Question: Summarize what this figure shows in one sentence.
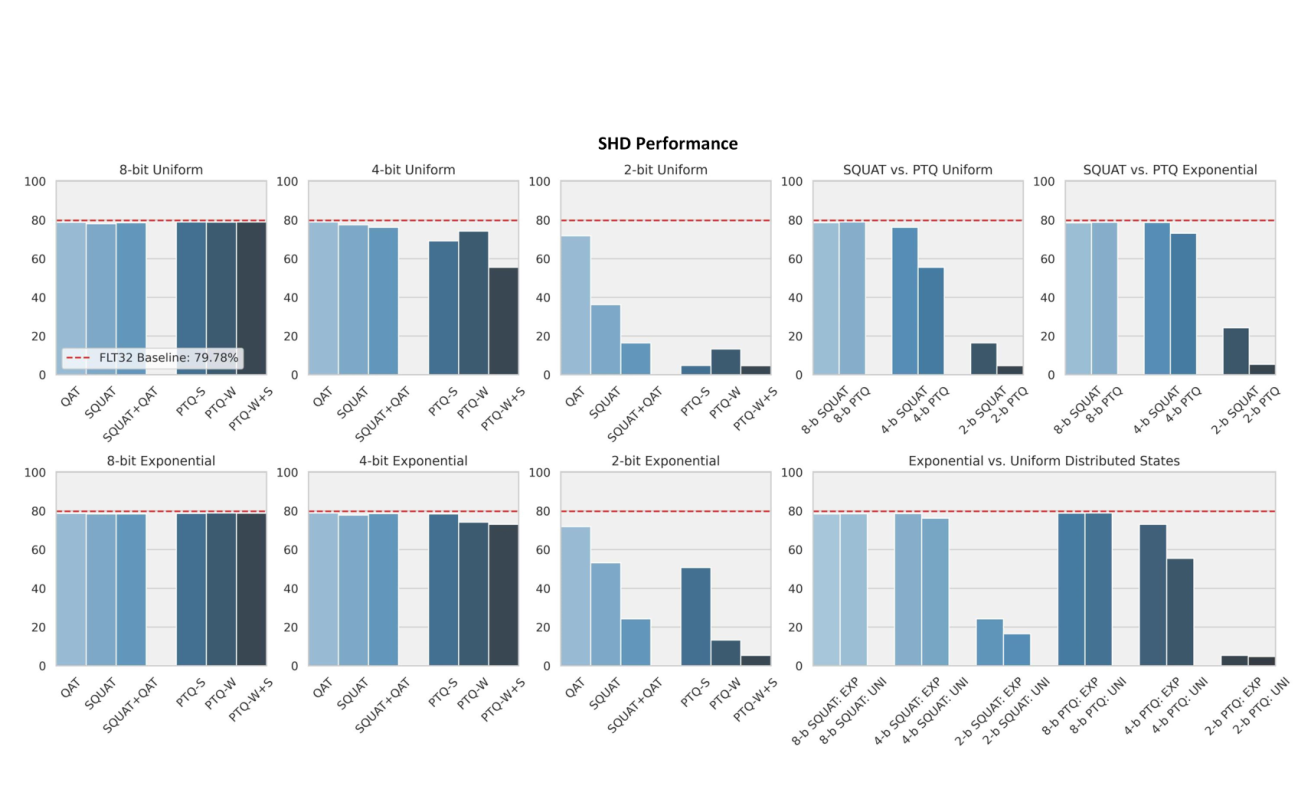
Answer: SHD performance. Top row: (i) 8/4/2-b uniformly distributed states across QAT (N-b weights, flt32 states), SQUAT (flt32 weights, N-b states), SQUAT+QAT (N-b weights, N-b states), and PTQ-S (flt32 weights, N-b states), PTQ-W (N-b weights, flt32 states), PTQ-W+S (N-b weights, N-b states). (ii) SQUAT vs PTQ uniformly and exponentially distributed states (SQUAT and QAT are both applied across N-b weights and states, and compared against PTQ of N-b states and weights). Bottom row: (iii) 8/4/2-b exponentially distributed states across QAT (N-b weights, flt32 states), SQUAT (flt32 weights, N-b states), SQUAT+QAT (N-b weights, N-b states), and PTQ-S (flt32 weights, N-b states), PTQ-W (N-b weights, flt32 states), PTQ-W+S (N-b weights, N-b states). (iv) Comparison between exponential and uniformly distributed states: SQUAT+QAT are used across N-b states and weights, then N-b PTQ is used across N-b states and weights.